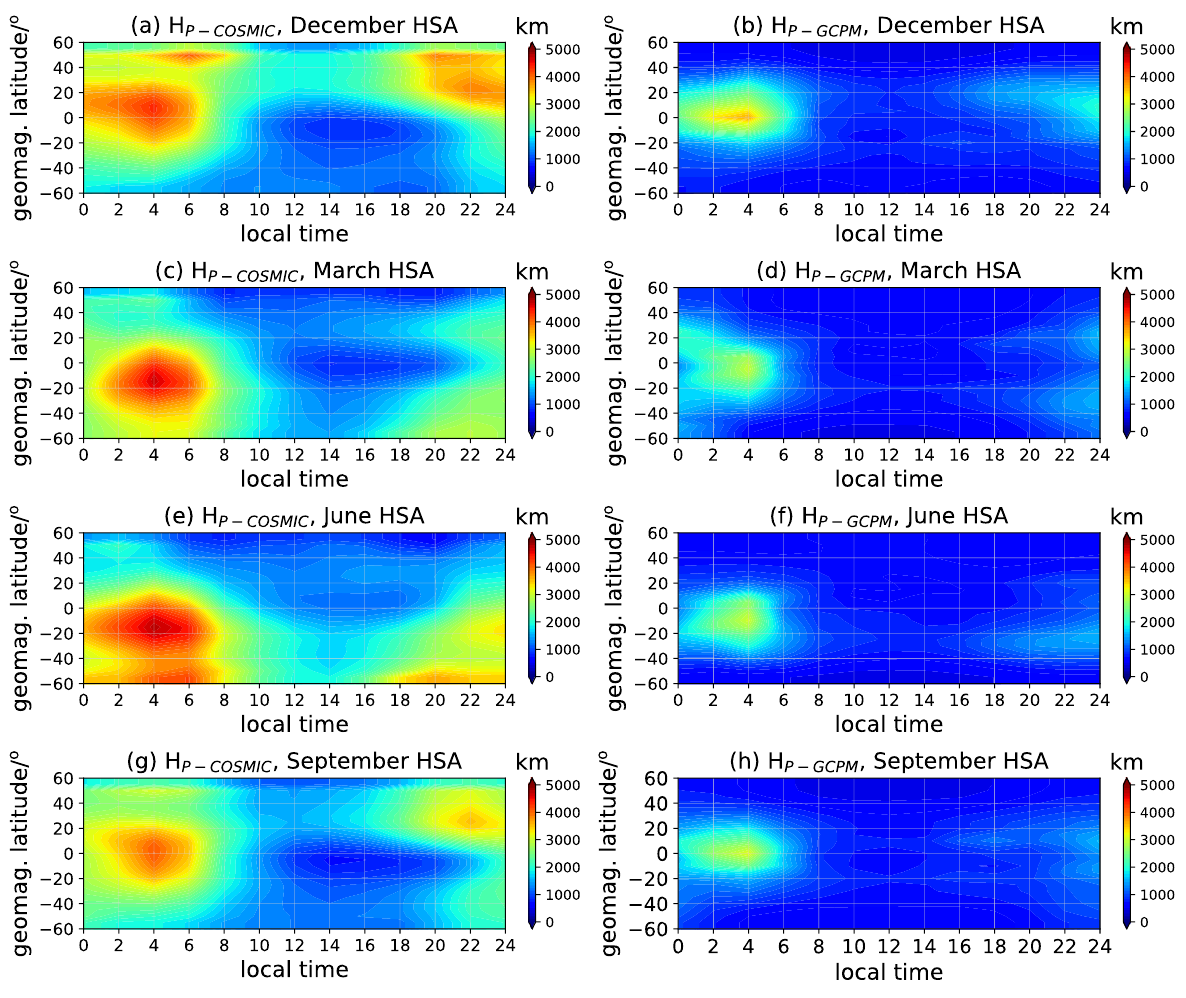
Figure 4. Same as Figure 3 but for the HSA year.